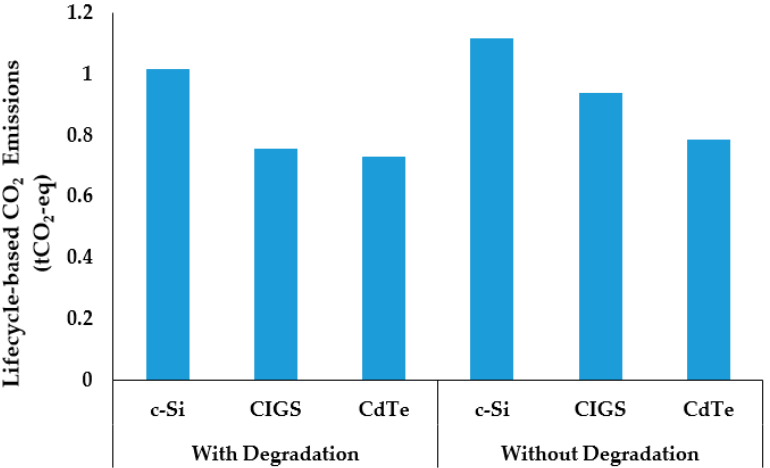
Figure 13. Lifecycle-based CO 2 emissions per the produced electricity by the 3-L SPVT system with and without degradation.